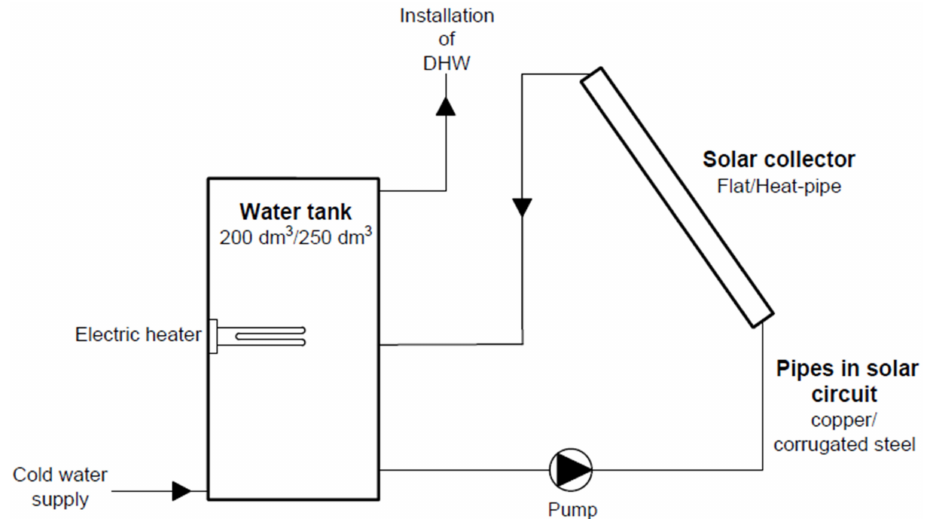
Figure 1. Scheme of the simulated